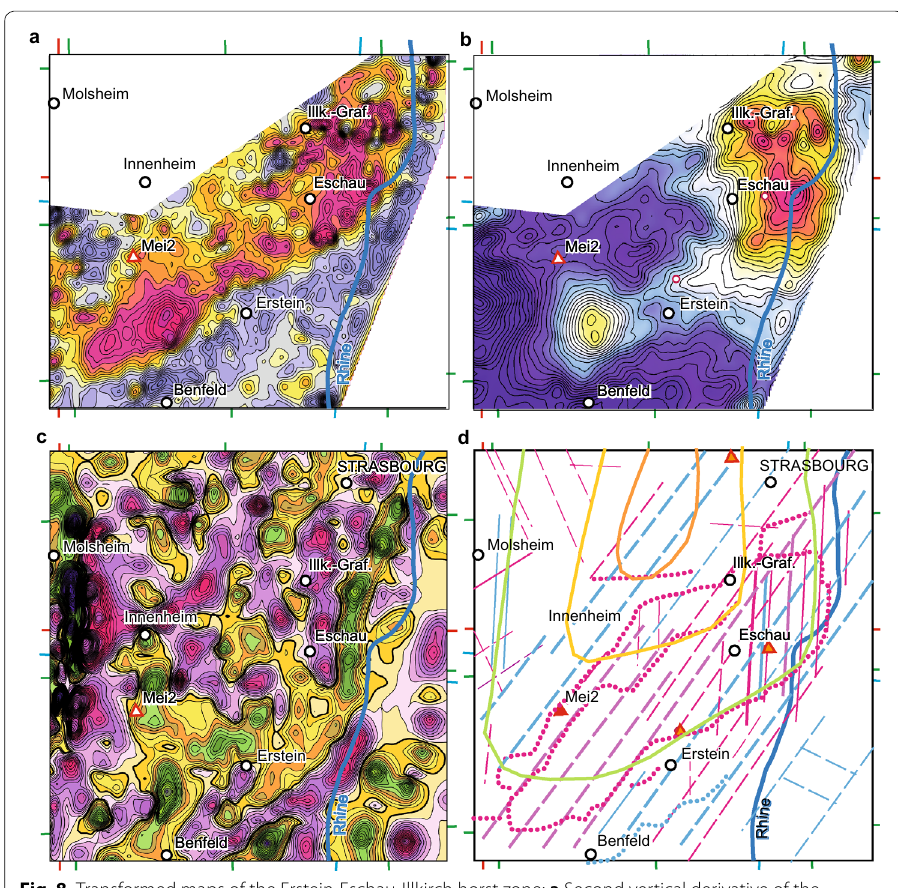
Fig. 8 Transformed maps of the Erstein-Eschau-Illkirch horst zone: a Second vertical derivative of the aeromagnetic map reduced to the pole and upward continued by 150 m. b Analytical signal of the aeromagnetic map. c Second vertical derivative of the Bouguer anomalies. Gravimetric data from the 2015 survey are added to the Rotstein et al. (2006) dataset. d Structural interpretation of the geophysical maps: red/blue dots magnetic/gravimetric boundaries, red/blue full and dashed lines = faults and discontinuities. Violet lines represent both magnetic and gravimetric faults and discontinuities. The whole is superimposed with temperature lines at 100 °C (green), 110° (yellow) and 120° (orange) at 2000-m depth from Fig.